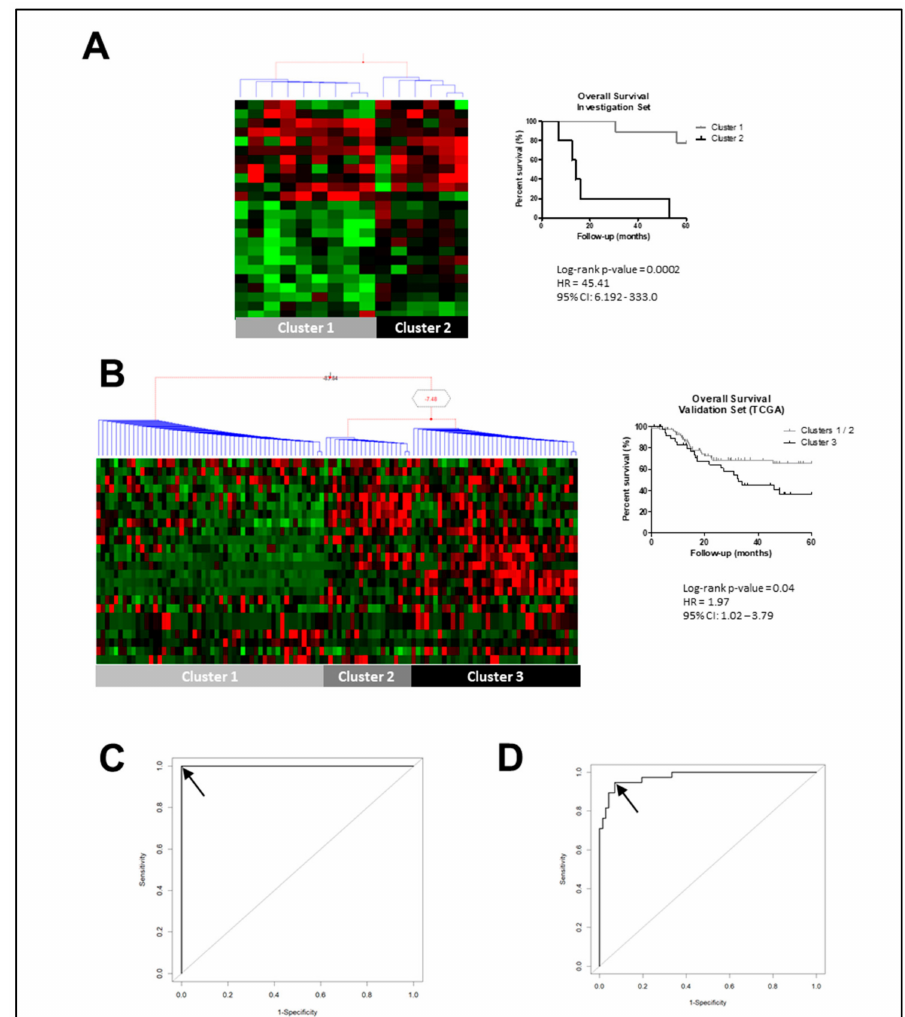
Figure 1. Laryngeal squamous cell carcinoma (LSCC) transcriptome analysis pointed out the gene expression signature associated with prognosis. ( A ) Bayesian hierarchical clustering with the expression of gene-pattern signature associated with LSCC prognosis was capable to segregate Brazilian National Cancer Institute (INCA) LSCC samples into two clusters. Kaplan–Meier curve analysis shows prognosis di ff erences between LSCC samples according to gene-expression signature, with Cluster 1 samples presenting a significative better prognosis than Cluster 2 samples. ( B ) Applying the gene-prognosis panel to The Cancer Genome Atlas (TCGA) LSCC samples revealed three clusters from Bayesian hierarchical clustering, and Cluster 3 presented a worse prognosis than samples from Clusters 1 and 2. In the heatmaps, each column represents an individual sample and each line represents a gene expression. The red and green colors represent increased and decreased gene expression, respectively. Groups were made according to 24 overexpressed gene expressions associated with prognosis. ( C ) The 12-gene-expression panel ( ADH7 , ALCAM , CYP2C19 , GBP6 , LYPD6B , TPD52L1 , ODC1 , BTBD11 , PTGR1 , ME1 , C12ORF75 , and ACVR1 ) was capable to distinguish samples of Cluster 3, which presented worse prognosis, from those from Clusters 1 and 2 with an AUC of 1.0. ( D ) A three-gene panel with ALCAM , GBP6 , and ME1 expression values showed similar results to those from 12-gene panel, showing AUC of 0.97, sensitivity 94.7%, and specificity 93.1%. Legend: HR, hazard ratio; CI, confidence interval; black arrow represents the selected ROC curve